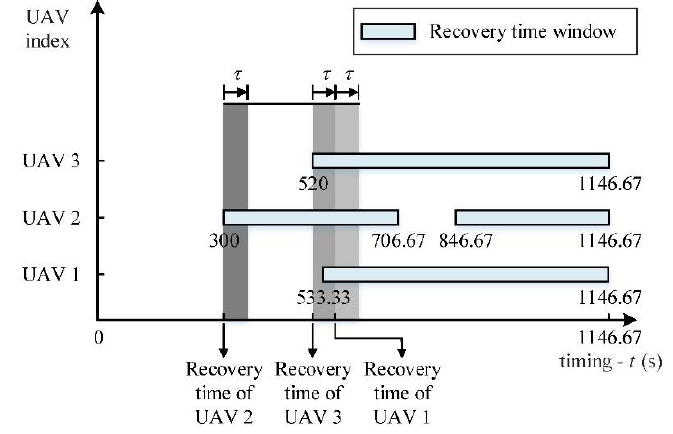
Figure 10. Recovery time of UAV 1, UAV 2, and UAV 3 when recovering all of them.